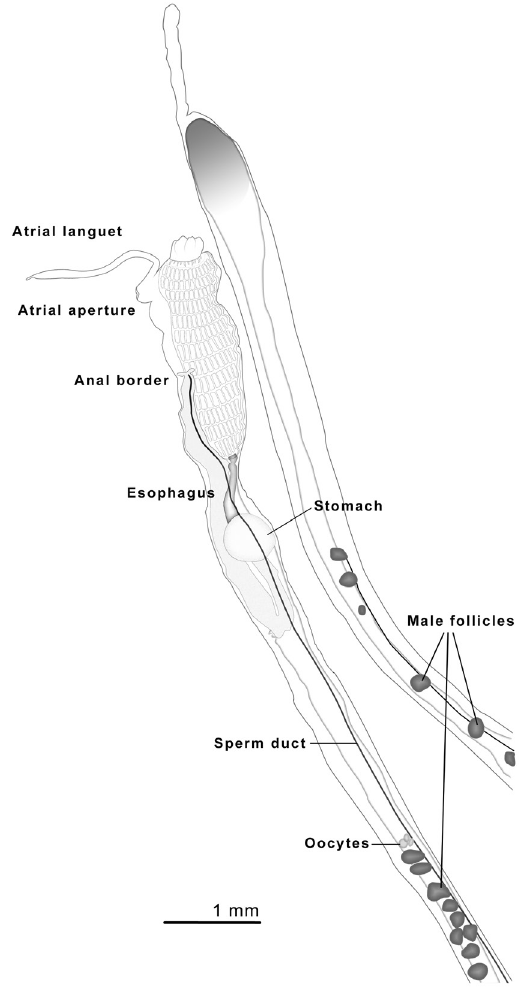
Figure 3. Zooid of Synoicum molle . Only the initial and last sections of the post-abdomen are